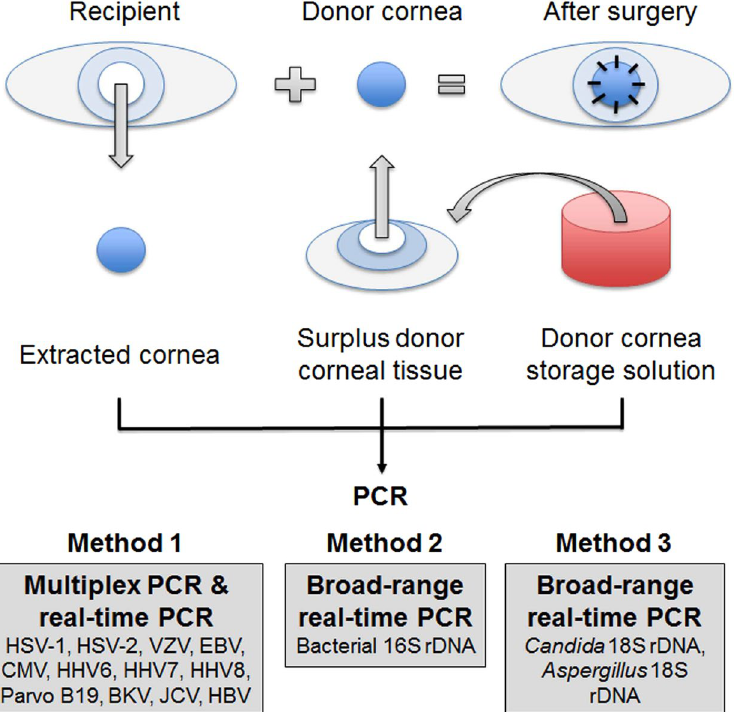
Figure 2. Diagram of method for comprehensive PCR analysis of pathogen DNA in extracted recipient corneal tissue, donor corneal tissue, and donor cornea storage solution. This method comprised the three following steps: (1) qualitative multiplex PCR and quantitative real-time PCR, (2) broad-range real time PCR, and (3) broad-range real time PCR. Method 1: DNA from the following pathogens was found in the extracted tissue, the donor tissue and storage solution: HSV-1, HSV-2, VZV, EBV, CMV, HHV-6, HHV-7, HHV-8, BKV, JCV and HBV. Method 2: broad-range real time PCR in the extracted tissue, donor tissue, and storage solution revealed the presence of bacterial 16s rDNA. Method 3: broad-range real time PCR in the donor cornea storage solution revealed the presence of Candida and Aspergillus 18s rDNA. BKV = BK virus ; HBV = hepatitis B virus ; CMV = Cytomegalovirus ; EBV = Epstein–Barr virus ; HHV-6-8 = human herpes virus type 6-8 ; HSV-1, 2 = herpes simplex virus type-1 , 2 ; JCV = JC virus ; Parvo B19 = human parvovirus B19; PCR = polymerase chain reaction; VZV = varicella-zoster virus